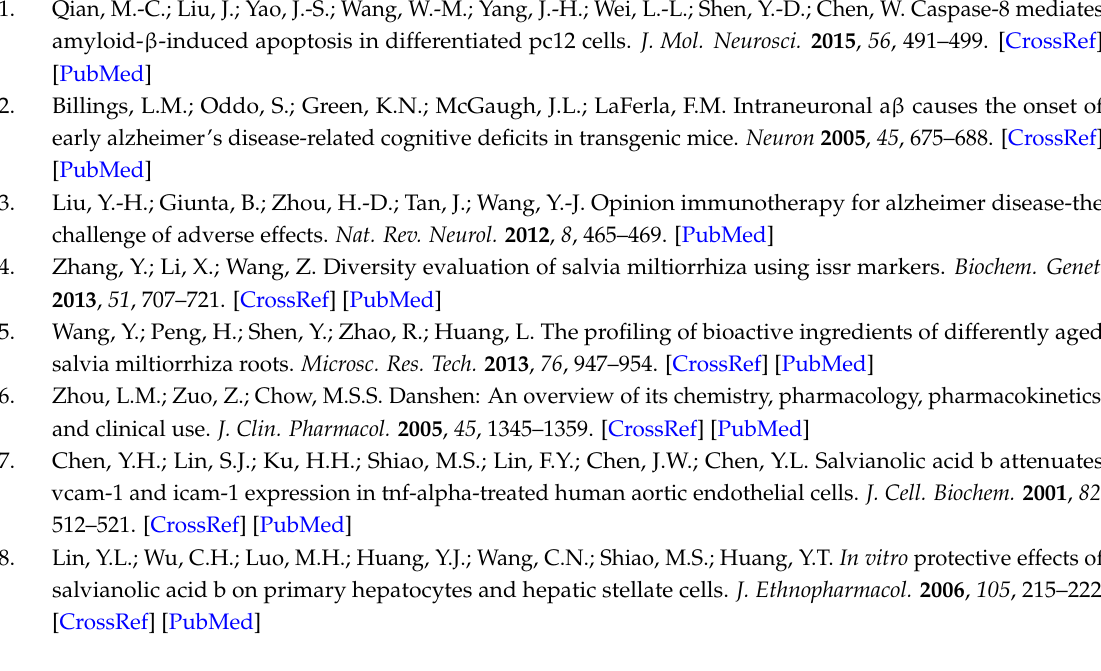
Figure S1: Effect of SalB on cell viability, A β 40 and A β 42 levels in SH-SY5Y-APPsw cells. Cell viability ( A ); A β 40 ( B ) and A β 42 levels ( C ) were measured in SH-SY5Y-APPsw cells. Values are expressed as the mean ˘ SD in each group ( n = 3). * p < 0.05, ** p < 0.01 vs. control. SalB: Salvianolic acid